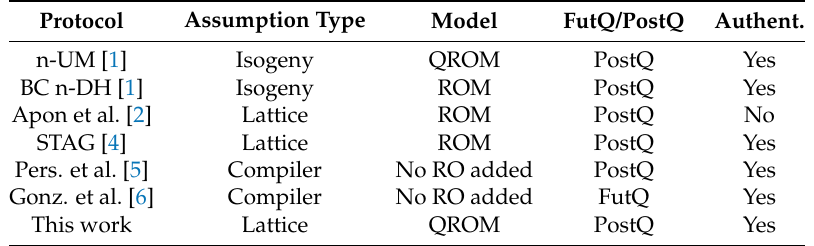
Table 2. Security of GKE/GAKE protocols claimed to be